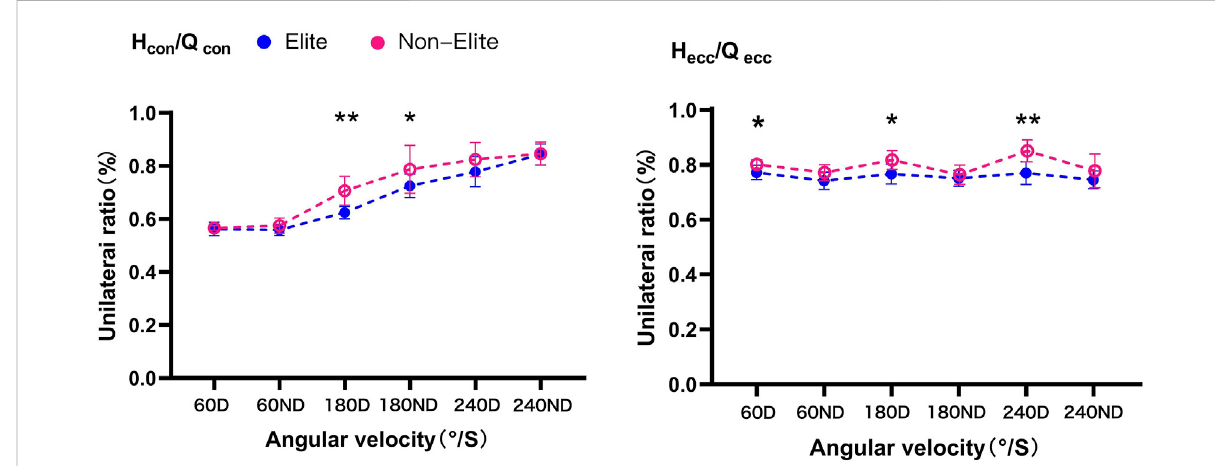
FIGURE 4 Unilateral ratio of hamstring (H) and quadriceps (Q) of the knee against 60 ° /S, 180 ° /S, and 240 ° /S in boxers. Differences between the elite and non-elite group were presented as * p < 0.05, ** p < 0.01; D, dominant limb; ND, non-dominant limb.